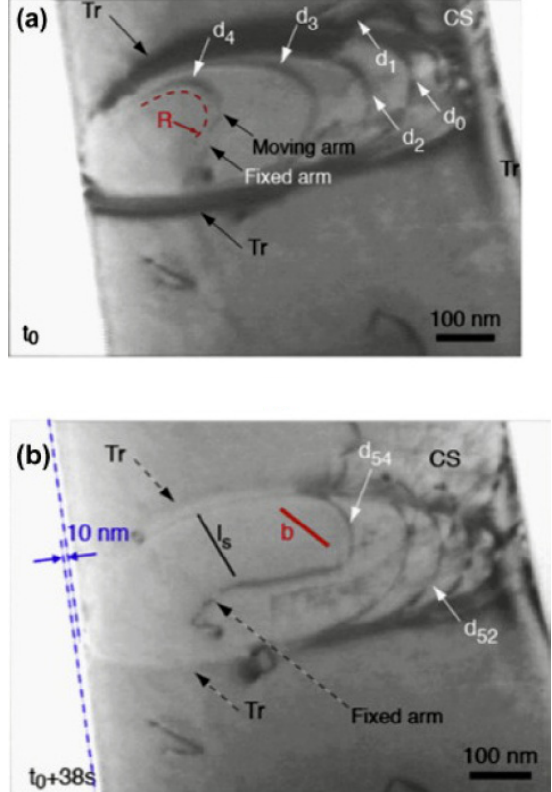
Fig. 18. Single arm source operating in a 750 nm wide Al fiber for a finite time (54 loop emissions in 38 s). (a) and (b) are video frames that correspond to the source operating and stopping,